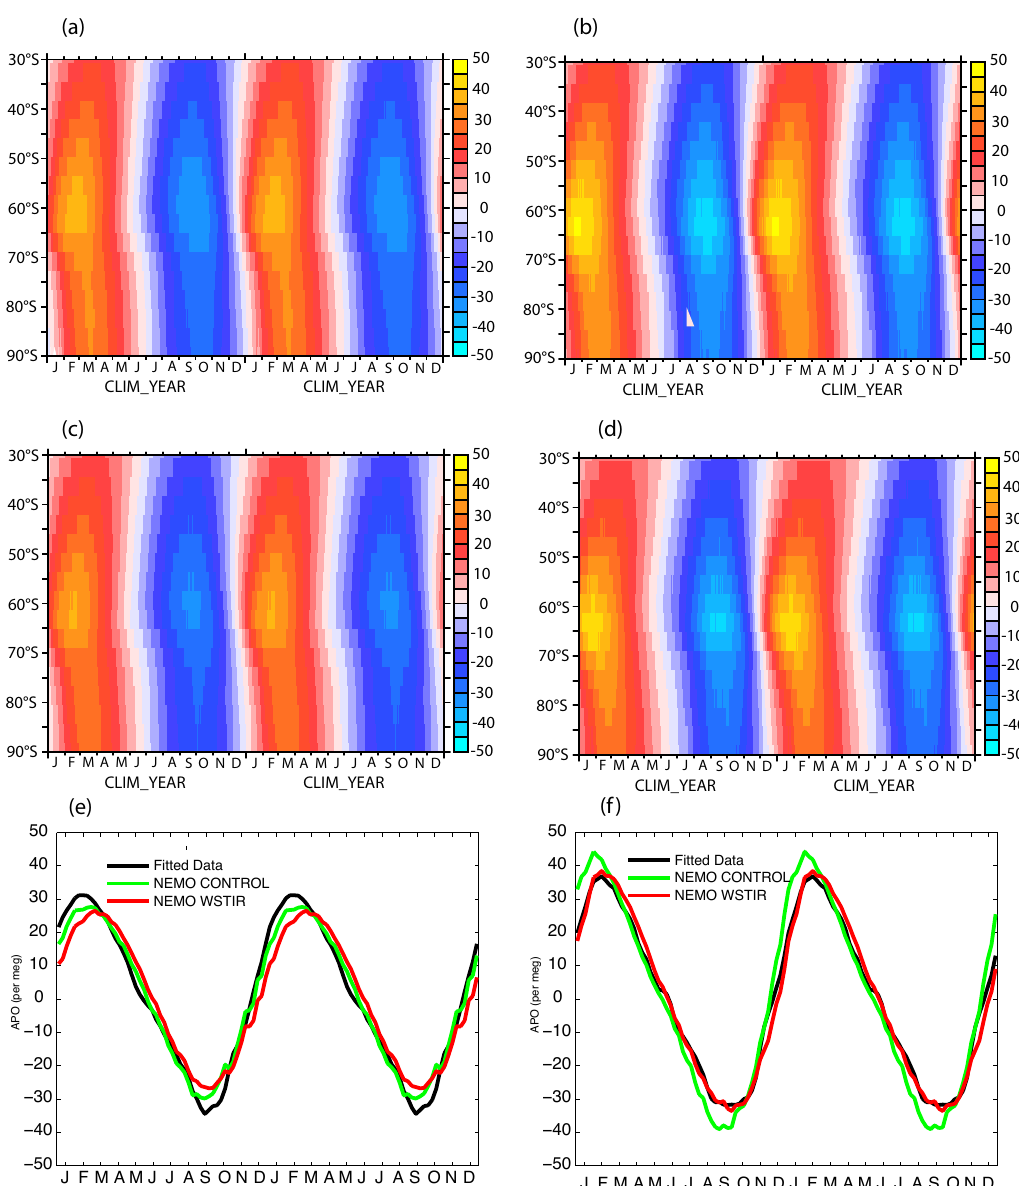
Figure 9. Atmospheric potential oxygen (APO) as simulated by the atmospheric transport model (ATM), in per meg units, for a detrendended climatological cycle. In each panel, the seasonal cycle is represented twice. Hovmöller diagram of canonical seasonal cycle of zonal mean surface APO for CNTRL case (a) ; Hovmöller diagram of canonical seasonal cycle of zonal mean surface APO for WSTIR case (b) ; Hov- möller diagram showing the relative contribution of O 2 to climatological APO variations for WSTIR (c) ; Hovmöller diagram showing the relative contribution of O 2 to climatological APO variations for CNTRL (d) ; Cape Grim, Australia (CGO): Repeated climatological seasonal cycle compared with observations from Scripps network; here the climatological seasonal cycle is calculated using the STL analysis tools of Cleveland et al. (1990) (e) . Palmer Station, Antarctica (PSA): Repeated climatological seasonal cycle compared with observations from Scripps network; Here the climatological seasonal cycle is calculated using the STL analysis tools of Cleveland et al. (1990) (f)